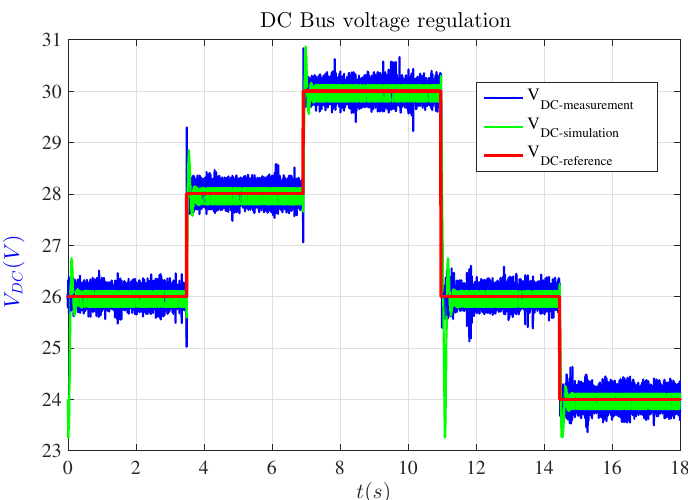
Figure 13. DC bus voltage regulation for different control parameters, at ω = 800 rpm and R L = 15 Ω .